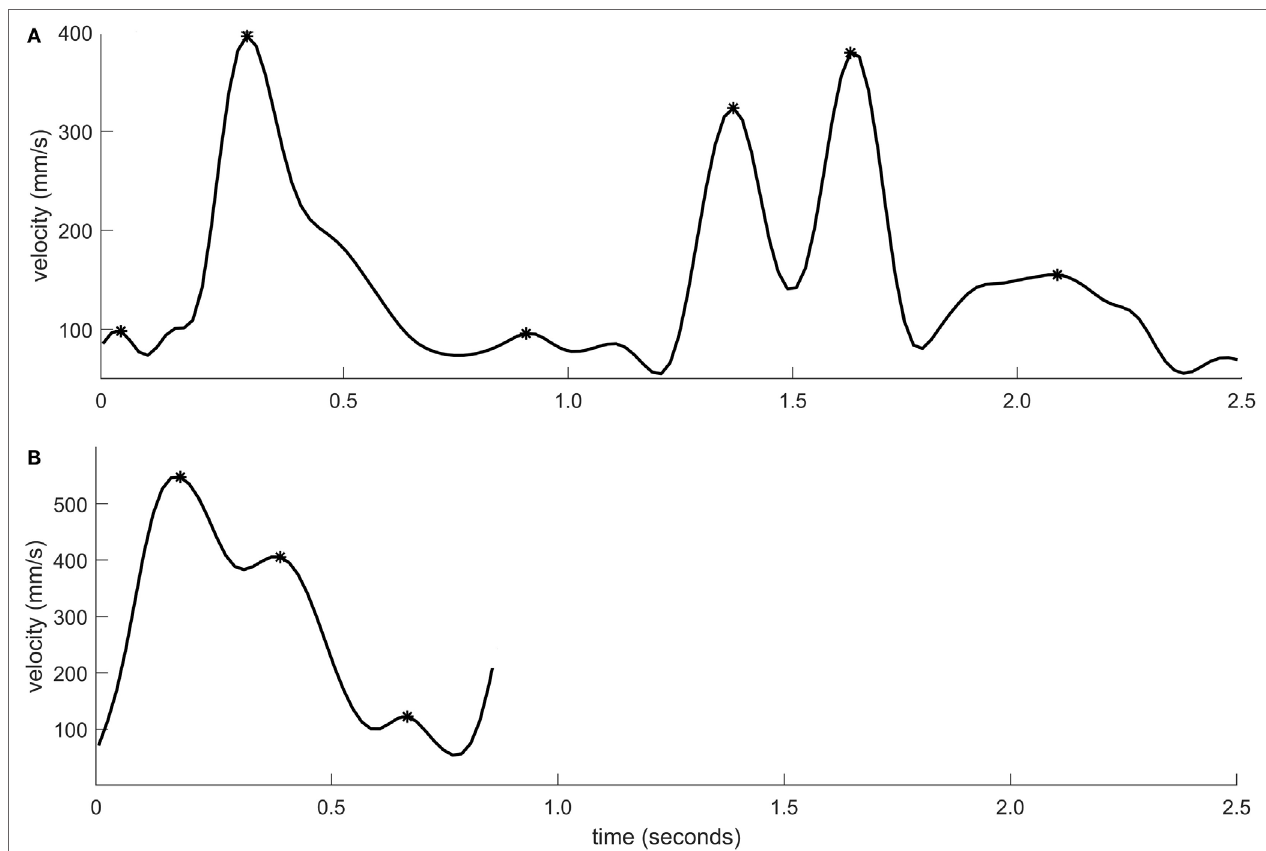
FigUre 3 | Velocity–time profile of a movement segment shown for one individual with moderate stroke impairment (a) and one healthy control (B) . The velocity peaks are marked using asterisk